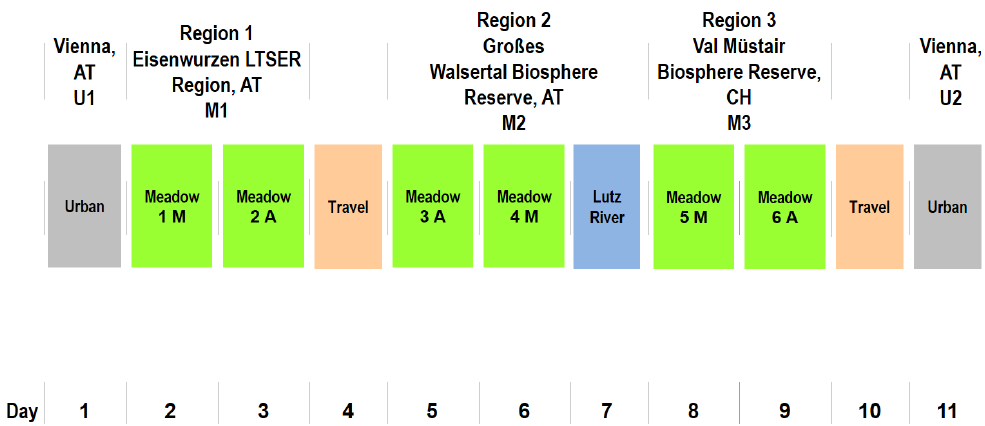
Figure 1. Sequence of exposures during the field trip (M = managed meadow; A = abandoned meadow).